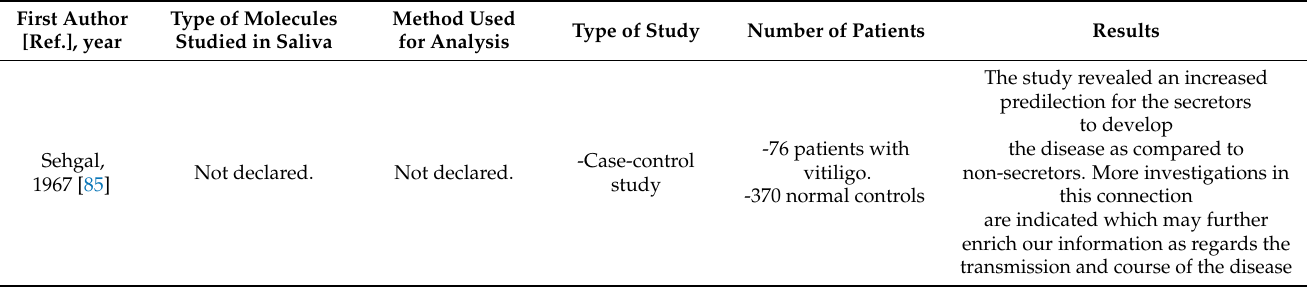
Table 3. Summary of the studies performed on the saliva of patients with